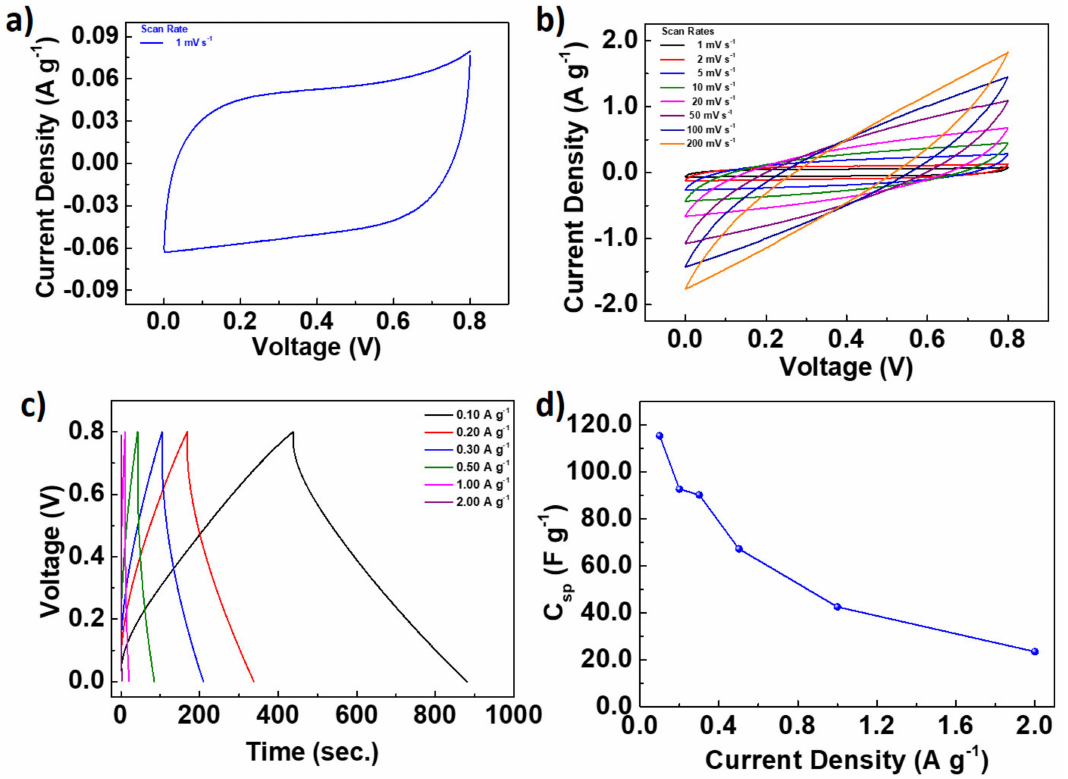
Figure 6. ( a ) CV results of the fabricated CH_K supercapacitors at a scan rate of 1 mV s − 1 . ( b ) CV re- sults of the fabricated devices at different scan rates. ( c ) GCD results of the fabricated supercapacitors at different current densities. ( d ) C sp of the CH_K supercapacitors as a function of current density. Lines are for visual